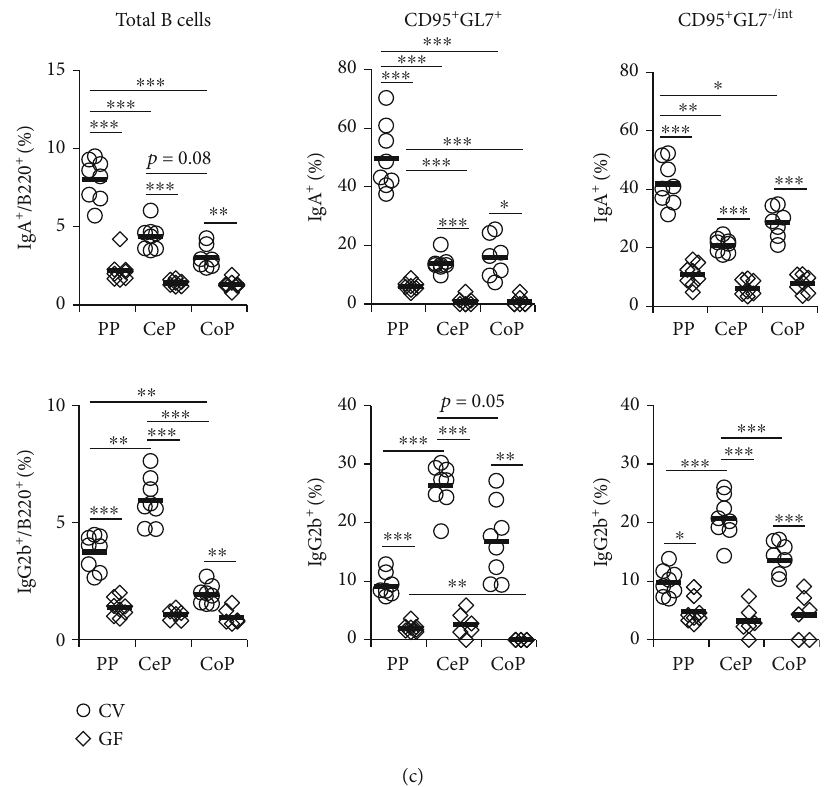
Figure 1: The role of gut microbiota in GC formation and antibody expression on B cells in the GALT of the small and large intestines. Flow cytometric analysis of mononuclear cells of GALT in CV and GF mice was performed. (a) Left panel: fl ow cytometric dot plot of CD95 and GL7 expression in B220 + cells. Right panel: percentage and absolute numbers of CD95 + GL7 + B220 + GC B cells and CD95 + GL7 -/int B220 + pre- GC B cells. (b) Left panel: fl ow cytometric dot plot of CXCR5 and PD-1 expression in CD4 + CD3 + cells. Right panel: percentage and absolute numbers of CXCR5 + PD-1 + CD4 + CD3 + Tfh cells. (c) The percentage of B220 + total B cells, CD95 + GL7 + B220 + GC B cells, and CD95 + GL7 -/ int B220 + pre-GC B cells expressing IgA or IgG2b. Data are shown as the mean ± SD and are representative of fl ow cytometric dot plots from six to eight independent experiments. ∗ p < 0 : 05 , ∗∗ p < 0 : 01 , and ∗∗∗ p < 0 : 001